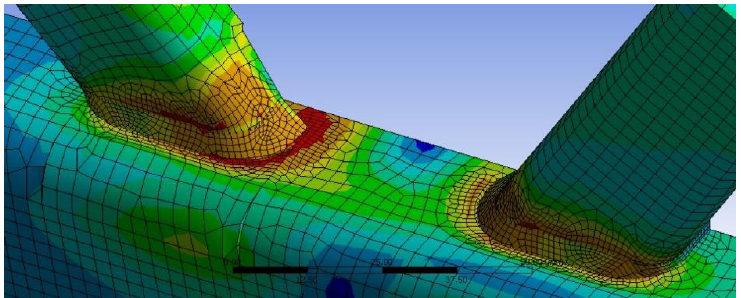
Figure 15. Failure in joint KC8 with V-notched hole and brace angles of 60°. Appl. Sci. 2019 , 9 , x FOR PEER REVIEW